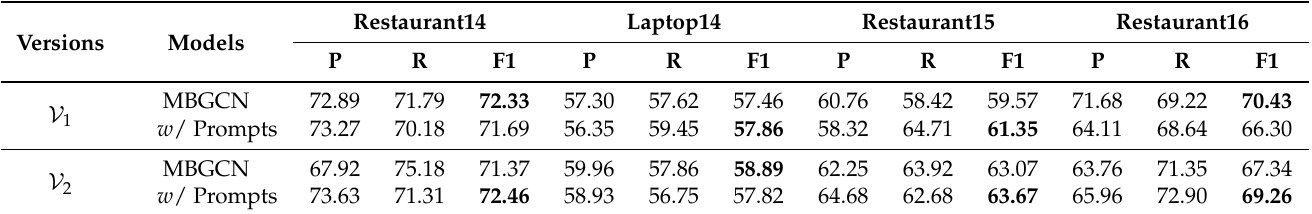
Table 6. The contribution of prompt learning to MBGCN for ASTE task on V 1 and V 2